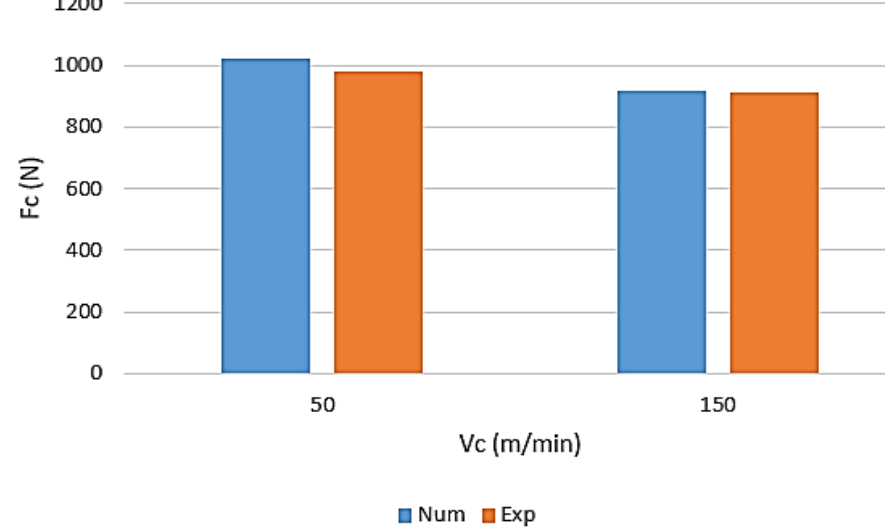
Figure 16. Computed tangential cutting force Fc (N) in function of cutting speed Vc (m/min).